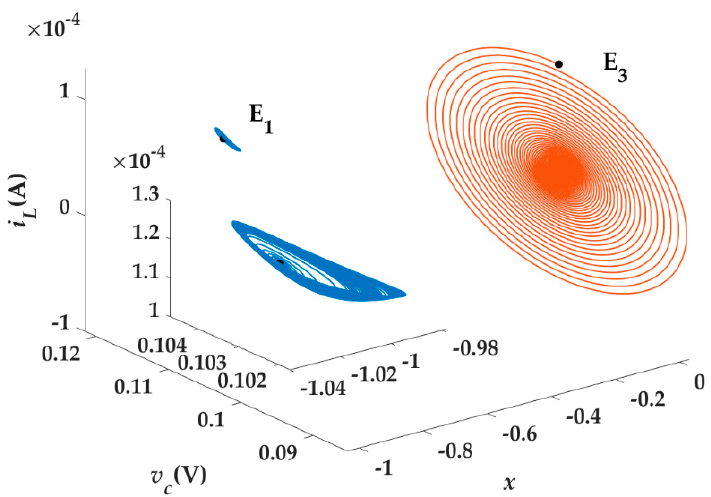
Figure 17. Two kinds of coexisting attractors of the system with different initial values.